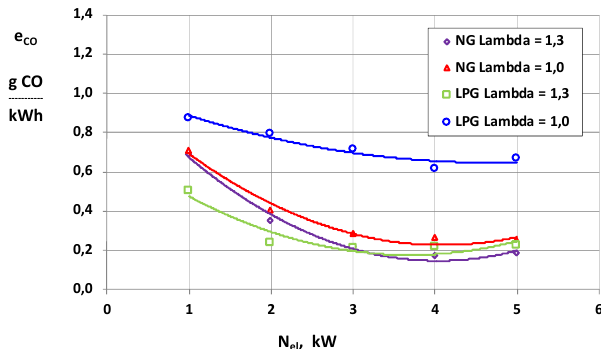
Fig. 5. Specific emission of CO vs mCHP unit output electric